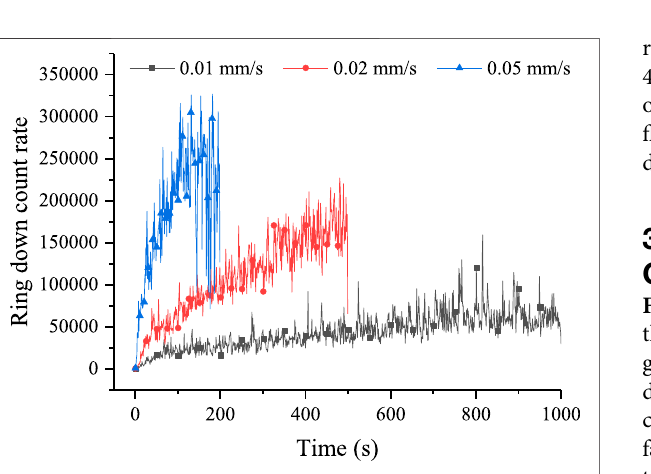
Frontiers in Earth Science |